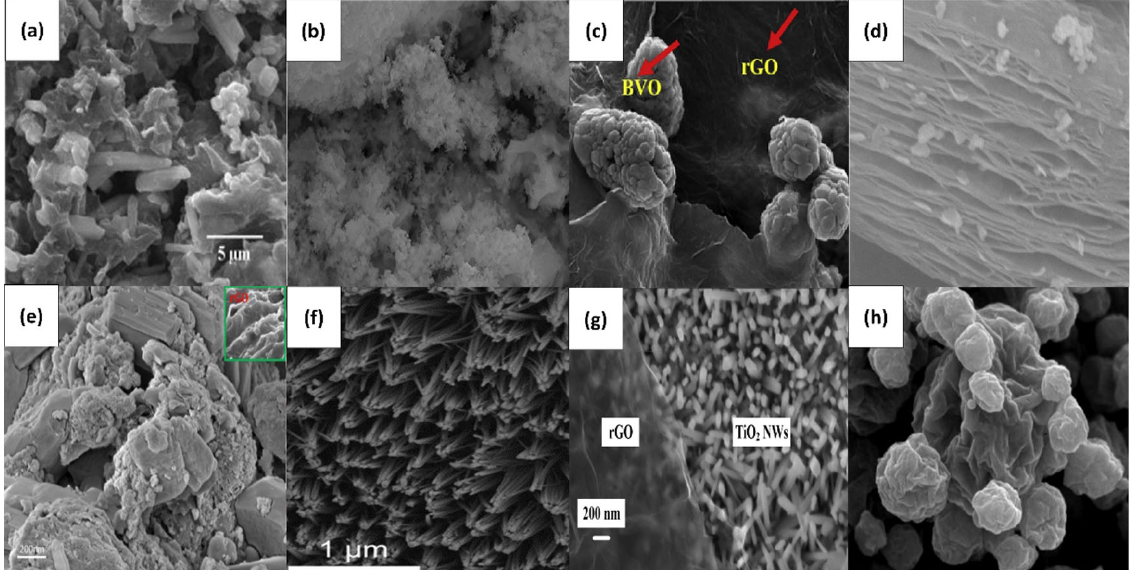
Figure 4. Variation of the nanocomposite morphologies observed with various integration strategies of semiconductors in the presence of rGO: ( a ) hydrothermal (ZnO/rGO), ( b ) sol ‐ gel (La 2 Zr 2 O 7 /rGO), ( c ) ultrasonication (BiVO 4 /rGO), ( d ) wet ‐ impregnation (rGO/ZnO), ( e ) co ‐ precipitation (rGO ‐ TiO 2 / Co 3 O 4 ), ( f ) electrospinning (ZnO/rGO), ( g ) electrophoretic dep ‐ osition (rGO/TiO 2 ), and ( h ) spray pyrolysis (rGO/TiO 2 ). The figure is reproduced with permission from [27,95,98,103,105,108,109,114].